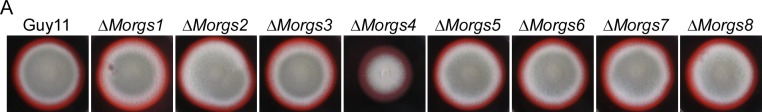
Measurement of activities of extracellular peroxidases.(A) The discoloration of Congo red was tested on the CM agar containing 200 mg/ml of the dye. Discoloration was observed on day 7 after inoculation at 28°C.